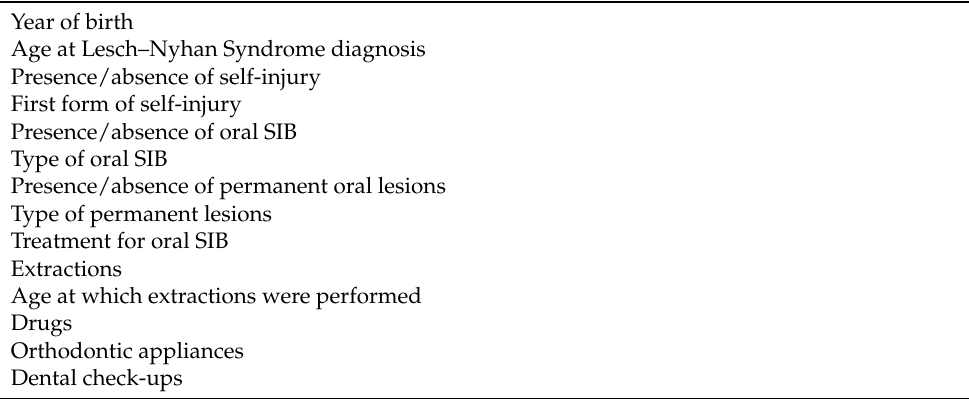
Table 1. Questionnaire used for the